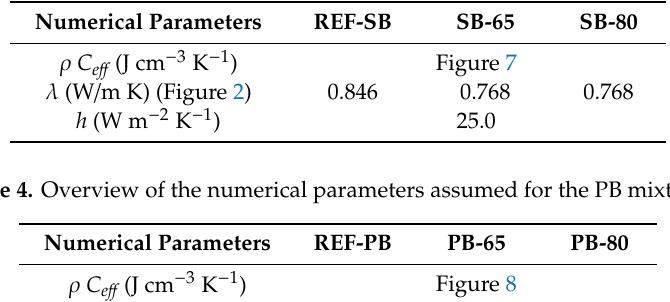
Table 3. Overview of the numerical parameters assumed for the SB mixtures.